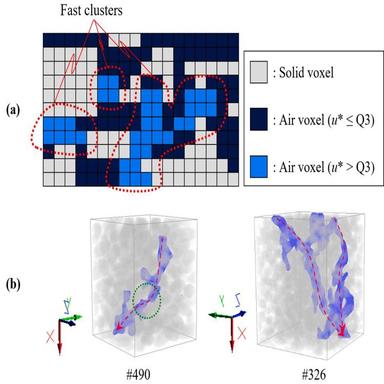
(a) Schematic explanation of the definition procedure of fast clusters. In this example, three fast clusters are shown. (b) Visualization of the largest cluster of voxels with velocities higher than Q3 of u\. The red broken arrows represent the persisted paths of the fast fluid, and the green dotted circle represents a contraction part in the cluster.